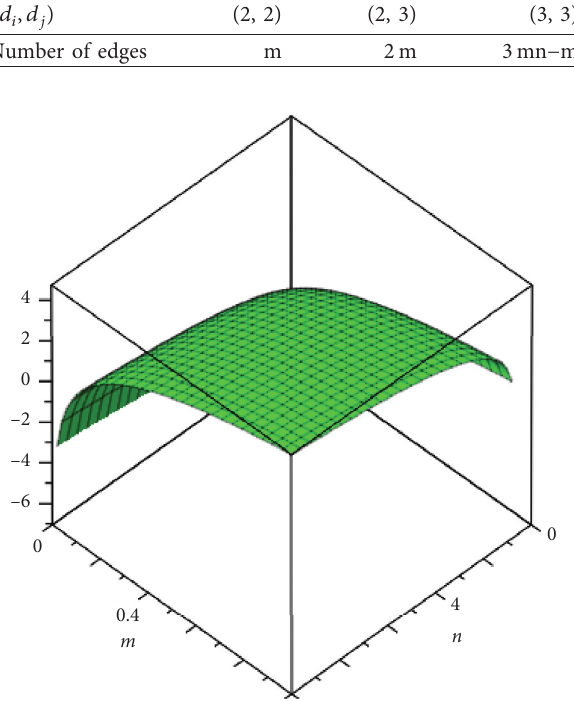
Figure 5: Plot of entropy of TUZC